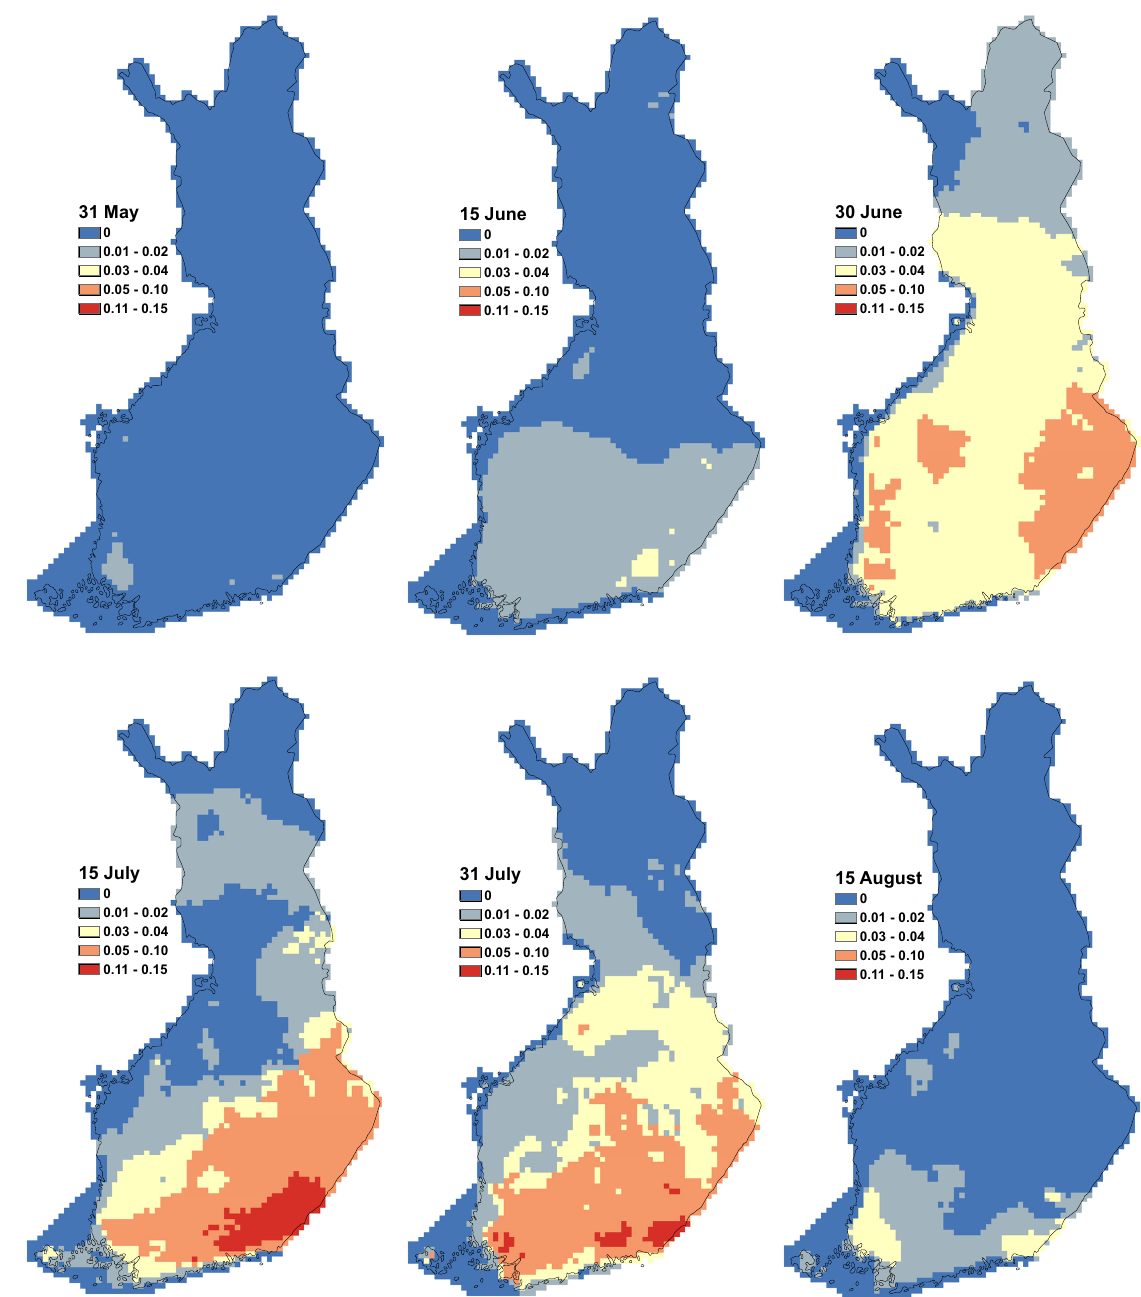
Fig. 4. Probabilities of heatwaves with daily maximum temperatures >25°C that lasted for at least five days (short episode) for the periods that ended on 31 May to 15